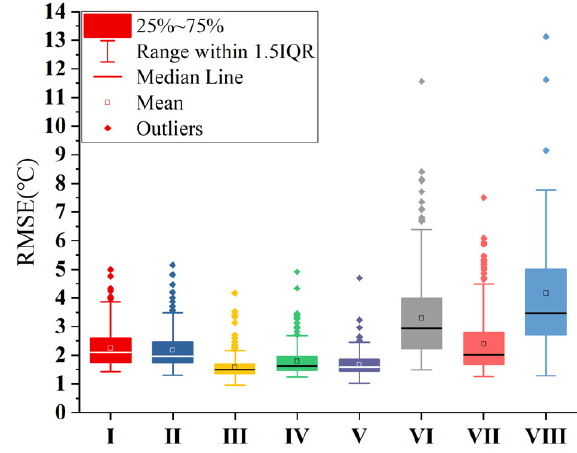
Figure 9. Box plot of RMSE for background in different regions.